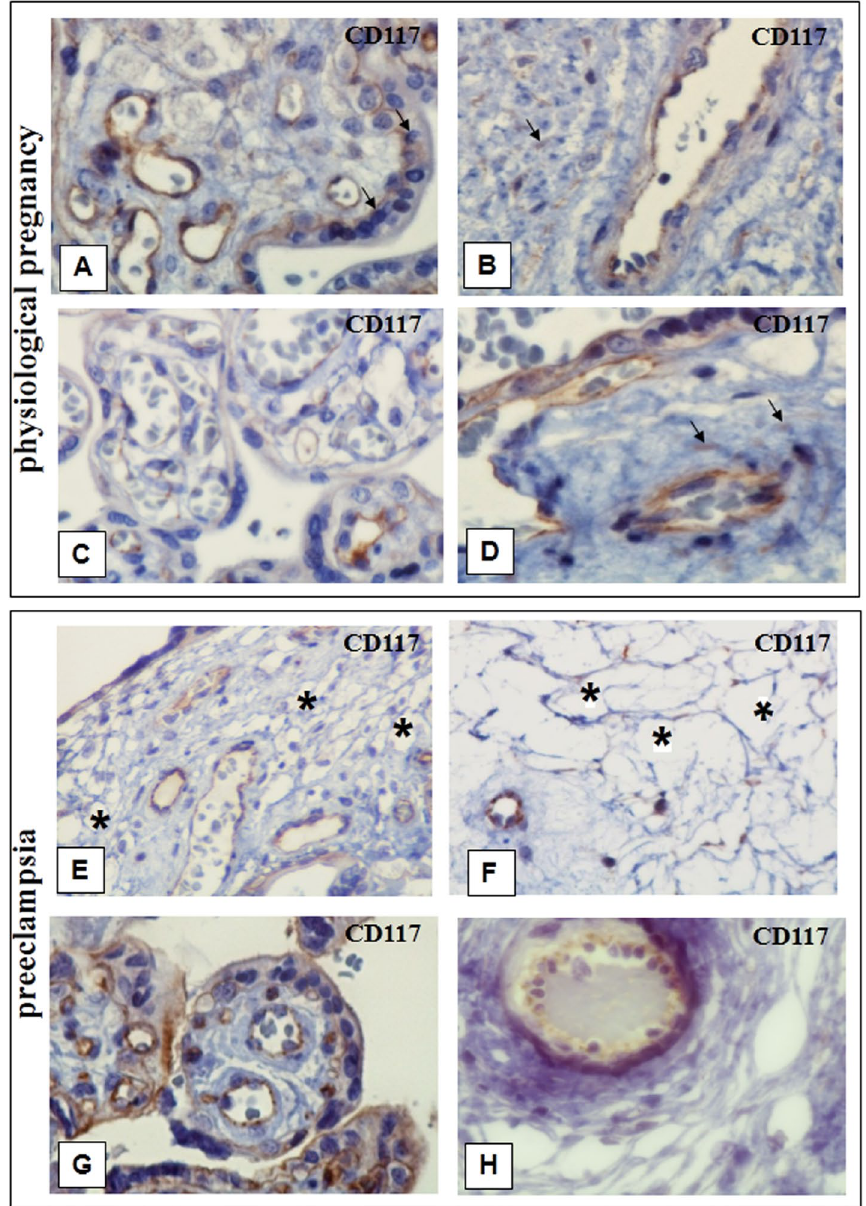
Figure 3. Immunohistochemical staining of placental villi with primary antibodies to CD117. in preeclampsia and physiological pregnancy. ( A–D ) Placental villous tree in a physiological pregnancy. ( А ) Intermediate villi (at the 27 th week). Weak staining of telocytes located under syncytiotrophoblast and deeper in the villi (only single cells) The telocytes located under the syncytiotrophoblast is weakly positive for the CD117 antibody, which is to be more intense in the blood vessel endothelium. (Processes of telocytes are marked with arrows), х400. ( B ) Stem villi (at the 27 th week). Weak staining of single myofibroblasts in the stem villus wall. The myofibroblasts are weakly positivity to the CD117 antibody. This signal is also weak in the blood vessel smooth muscle cells. However, the signal is more intense in the blood vessel endothelium. х600. ( С ) Intermediate villi (at the 39 th week): weak telocytes staining located under syncytiotrophoblast, and single telocytes deeper in villi), х600. ( D ) Stem villi (at the 39 th week). Positive staining of myofibroblasts in the wall, (Processes of telocytes are marked with arrows), х600. ( E and F ) Immature intermediate villi in early-onset PE (at the 27 th week). Staining of telocytes located under the syncytiotrophoblast and the staining of cells and their telopodes in the villus core (a large number of stromal channels formed by telocytes are present; the areas with disrupted connections between the cells and damaged telocytes and their telopodes are observed) (Stromal channels are marked with asterisks), ( E ) х400. ( F ) х600. ( G ) Intermediate villi in late-onset PE (at the 38 th week). Telocytes are only observed under the syncytiotrophoblast. There are single telocytes in the villous core. х400. CD117 expression observed in the endothelium and at the apex of the syncytiotrophoblast. In panel 3G, the stromal channels are negative to CD117, there is an intense positivity in the endothelium of large lumen blood vessels. ( H ) Stem villi in late-onset PE (at the 38 th week). The stromal channels remain (staining of the stroma from stem villi is negative). ( H )